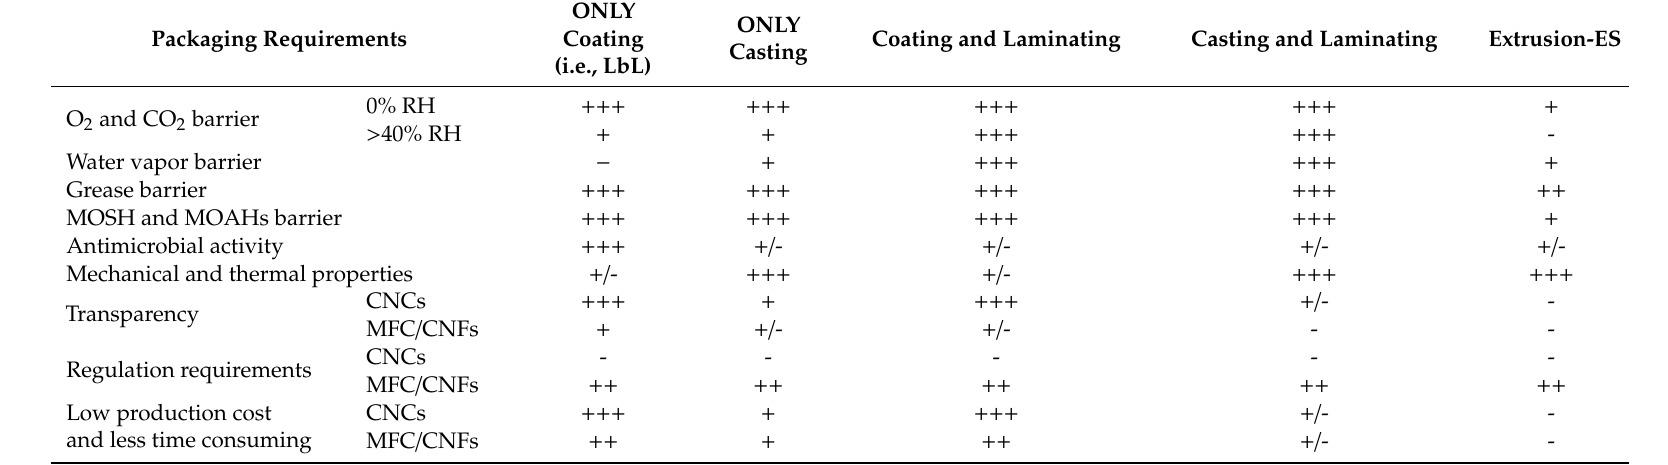
Table 5. Nanocellulose applications for packaging